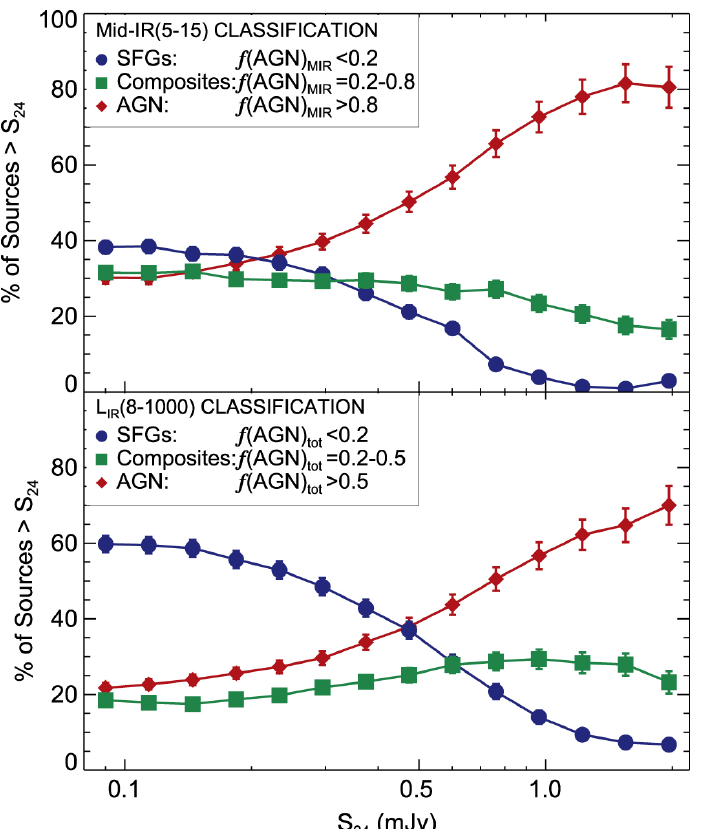
Figure 3. The relative contribution of SF-dominated, AGN-dominated and composite sources as a function of 24 µ m flux. These classifications are based on low resolution Spitzer -IRS spec- tra which are fitted with a model including PAH emission and continuum emission, the relative strength of which provides the fraction of AGN contribution to the mid-IR ( f ( AGN ) MIR ). Adapted from Kirkpatrick et al. [10], © AAS. Reproduced with